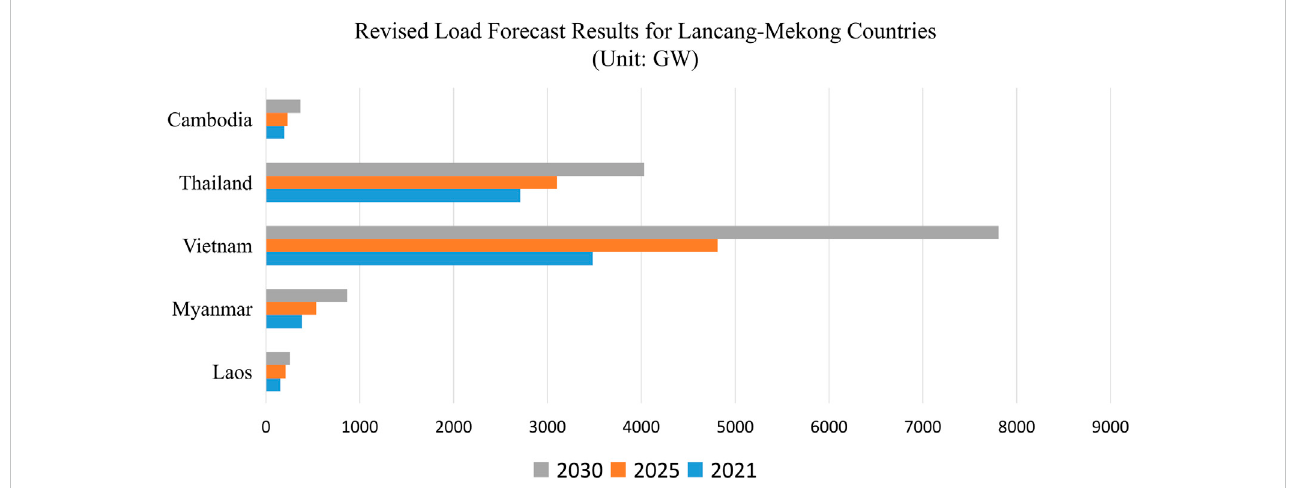
FIGURE 3 Revised load forecast results for Lancang- Mekong countries.